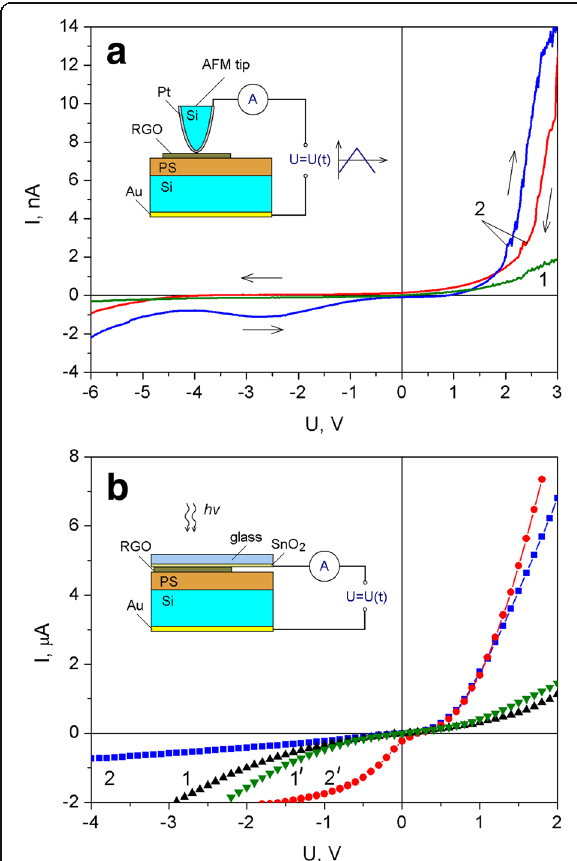
Fig. 4 Dark I-V curves (curves 1 and 2 ) and I-V curves after irradiation (curves 1 ’ and 2 ’ ) of the initial PS (curves 1 and 1 ’ ) and PS – RGO structures (curves 2 and 2 ’ ) performed using the AFM tip ( a ) and the ITO contact ( b ). Insets : schemes of the I-V curve measurement for experimental structures